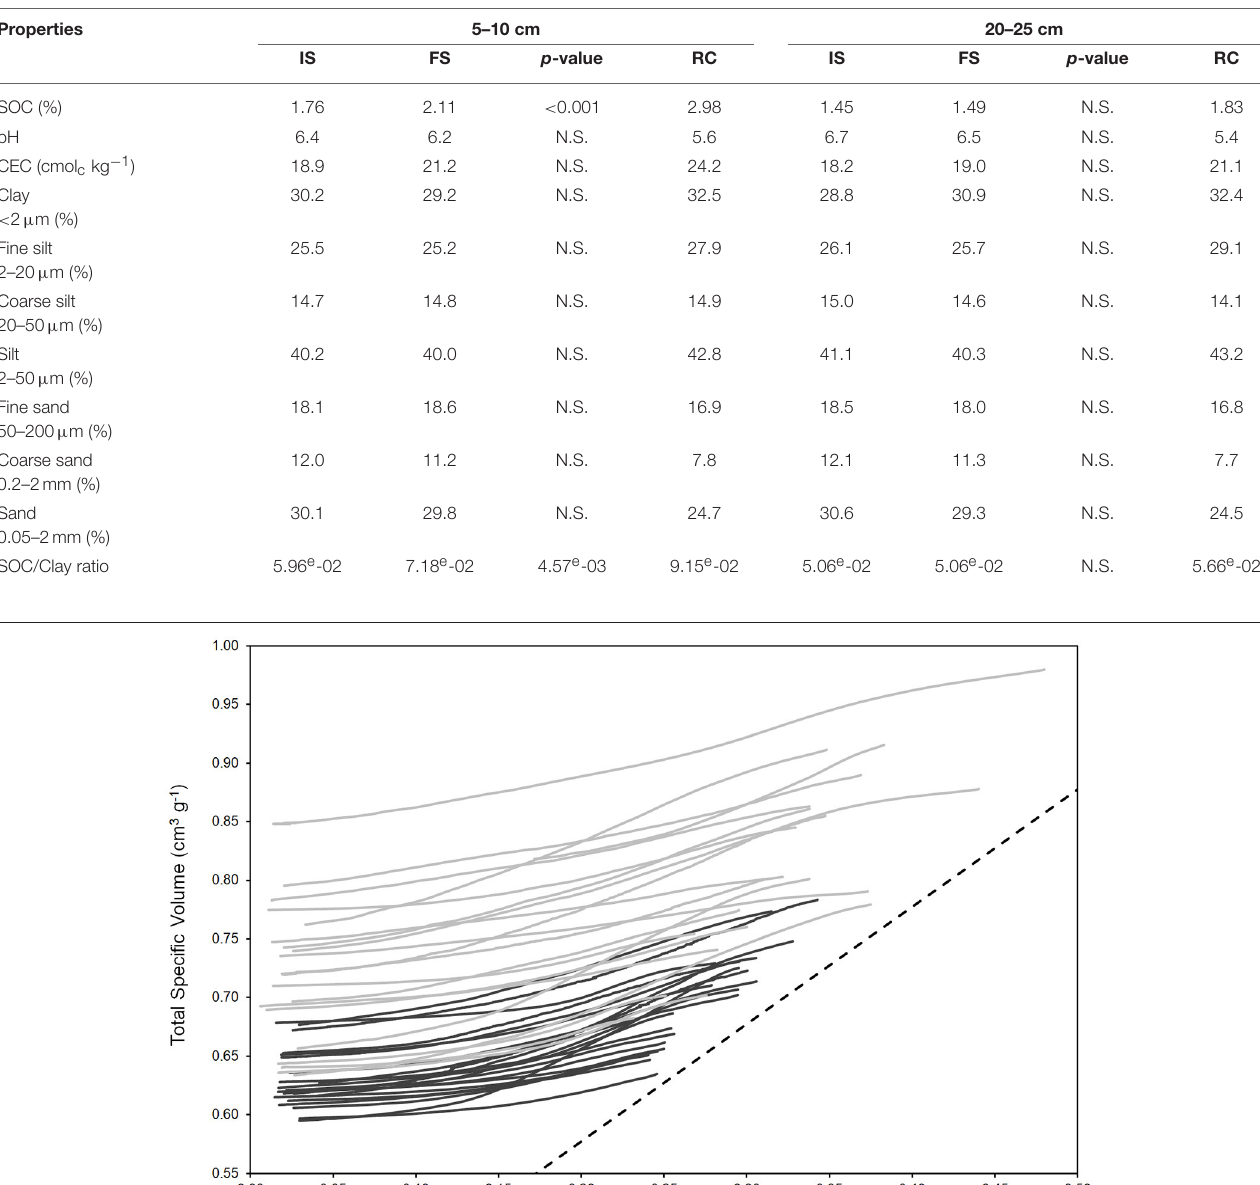
TABLE 1 | Mean soil characteristics, at initial state (IS), final state (FS), and reference condition (RC) for the 5–10 and 20–25 depths, and level of significance of the difference between IS and FS ( p -value). Properties